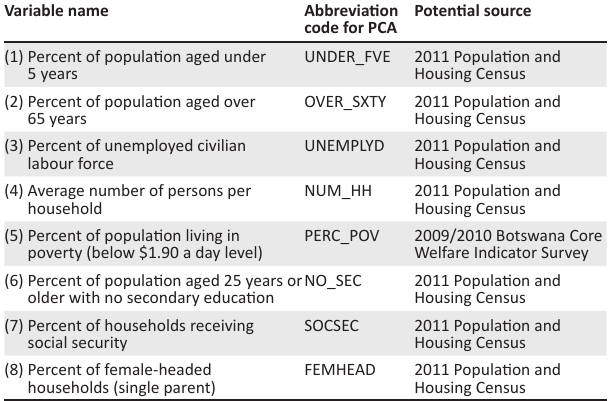
FIGURE 1: Botswana population and housing census districts, 2011. Census districts shown using circles are constituted by cities and mining TABLE 1: Original social vulnerability variables used for analysis.